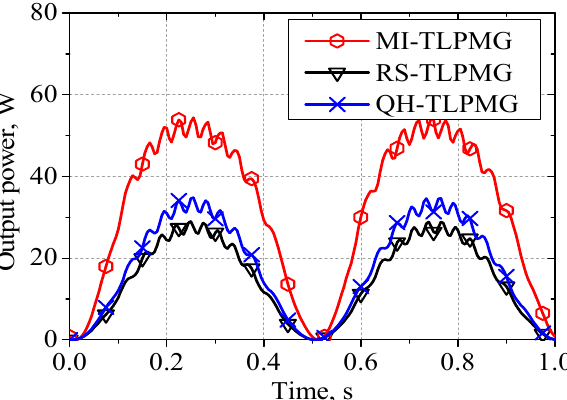
Figure 11. The instantaneous output power of MI-TLPMG, RS-TLPMG, and QH-TLPMG for 2 Ω at a sinusoidal speed of v ( t ) = 0.628cos ( 6.28 t ) .